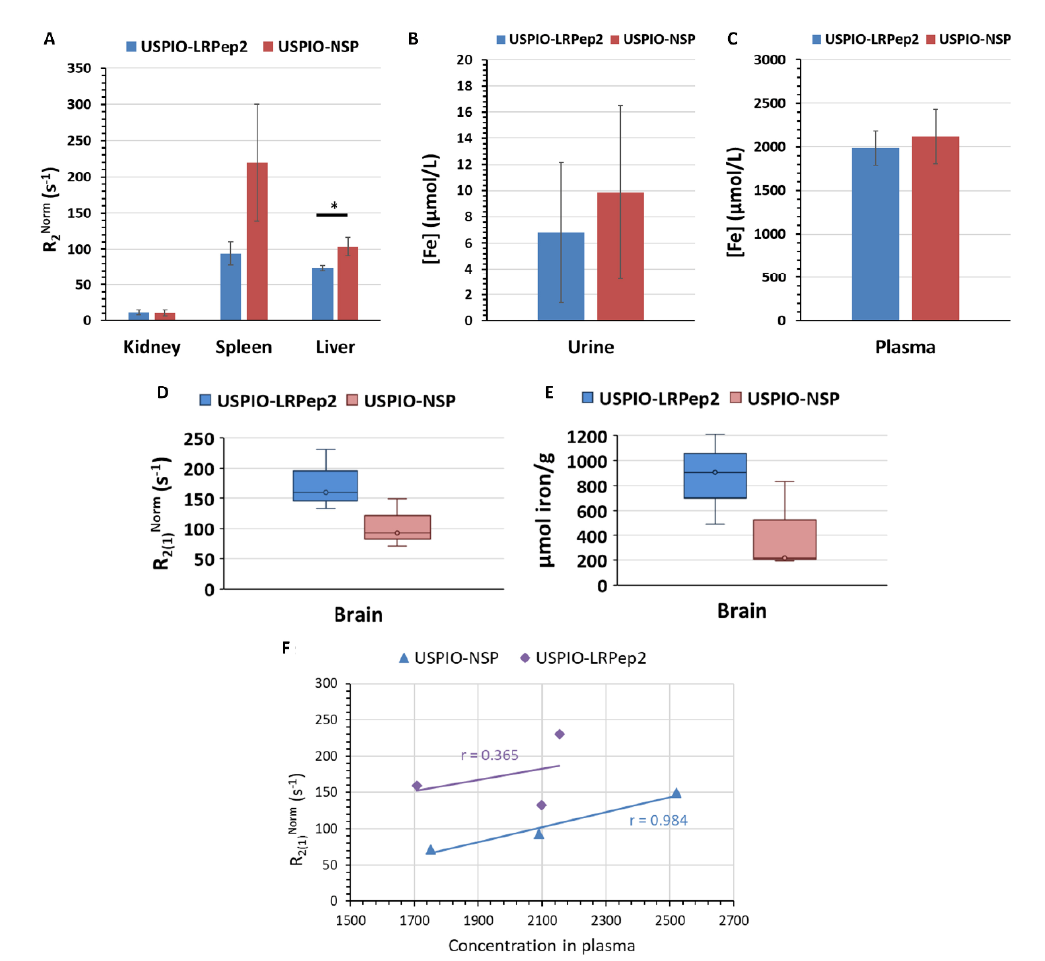
Figure 8. Biodistribution of USPIO-LRPep2 and USPIO-NSP at 55 min post-injection. ( A ) R 2Norm (=1/T 2Sample − 1/T 2Control ) for each USPIO derivative in the kidney, the spleen, and the liver. * p < 0.05. ( B ) and ( C ) Iron concentration (µmol/L) in urine and plasma, respectively. ( D ) R 2(1)Norm for each USPIO derivative in the brain. ( E ) Iron concentration (µmol/g of dried tissue) in brains after digestion in acidic conditions. ( F ) Correlation coefficients between the R 2(1)Norm of USPIO derivatives in the brains and their concentrations in the blood.